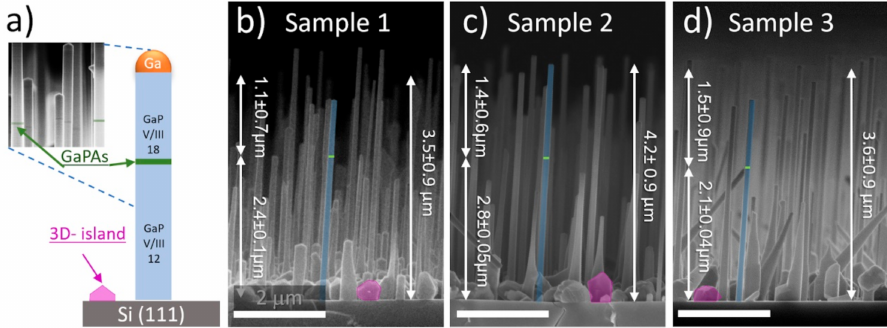
Figure 1. ( a ) schematic representation of the two-staged growth procedure; ( b – d ) Cross-sectional SEM-images of the studied GaP NW